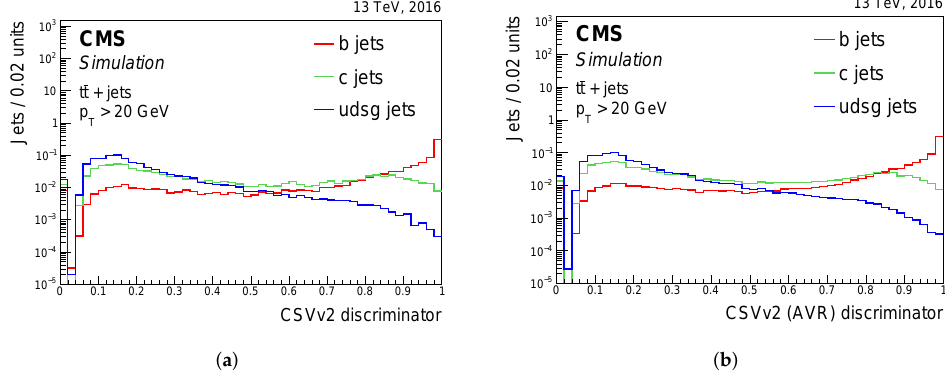
Figure 2. Distribution of the CSVv2 discriminant for jets of different flavour in t¯t events: the output for the version with ( a ) IVF reconstruction and with ( b ) AVR reconstruction. The distributions are normalised to unit area. Jets without a selected track and secondary vertex are assigned a negative discriminator value. The first bin includes the underflow entries